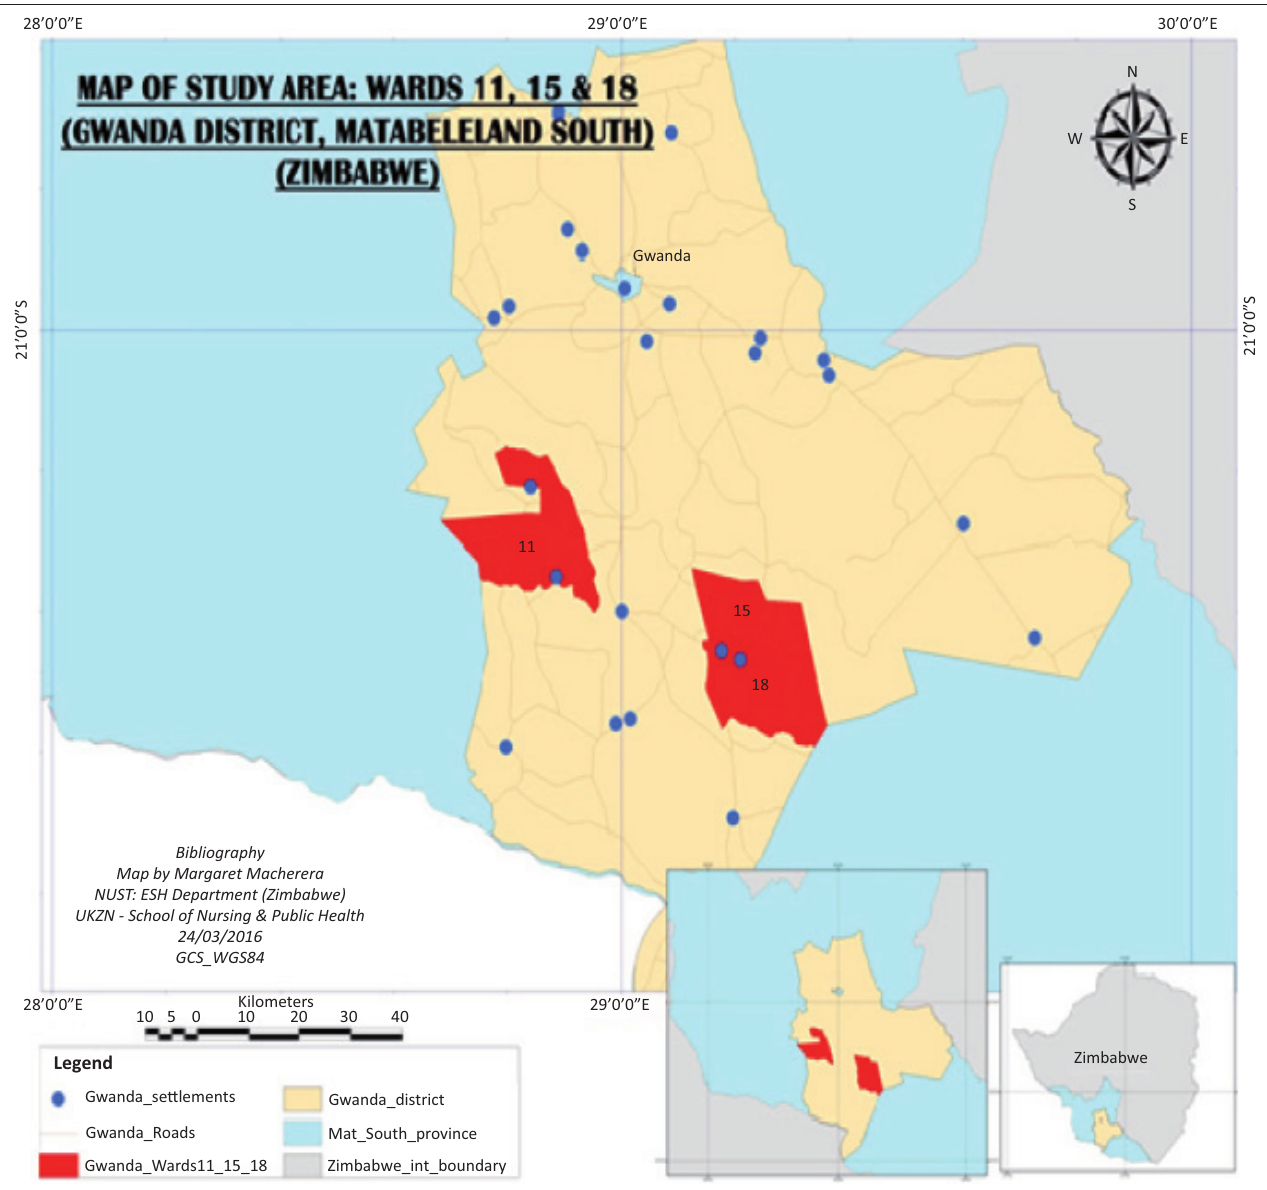
FIGURE 1: Map showing the study are wards 11, 15 and 18 in Gwanda District